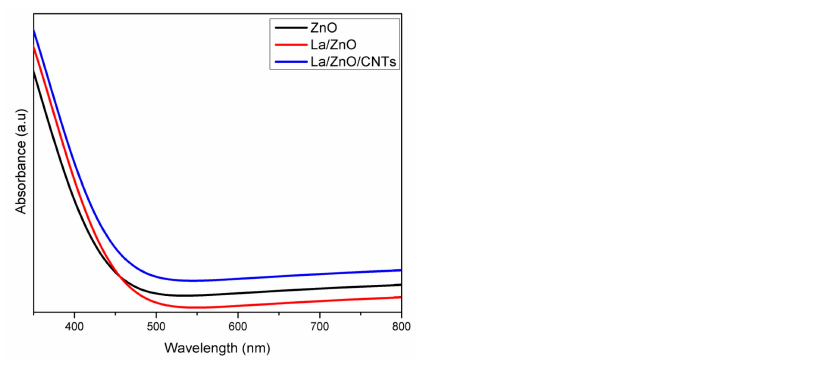
Figure 8. Optical absorption spectra of pristine ZnO, La/ZnO, and La/ZnO/CNTs composite photocatalyst.